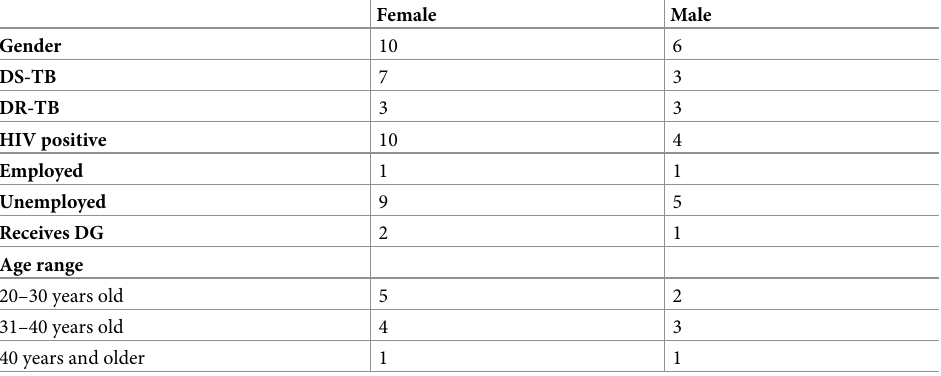
Table 2. Details of TB patients in the